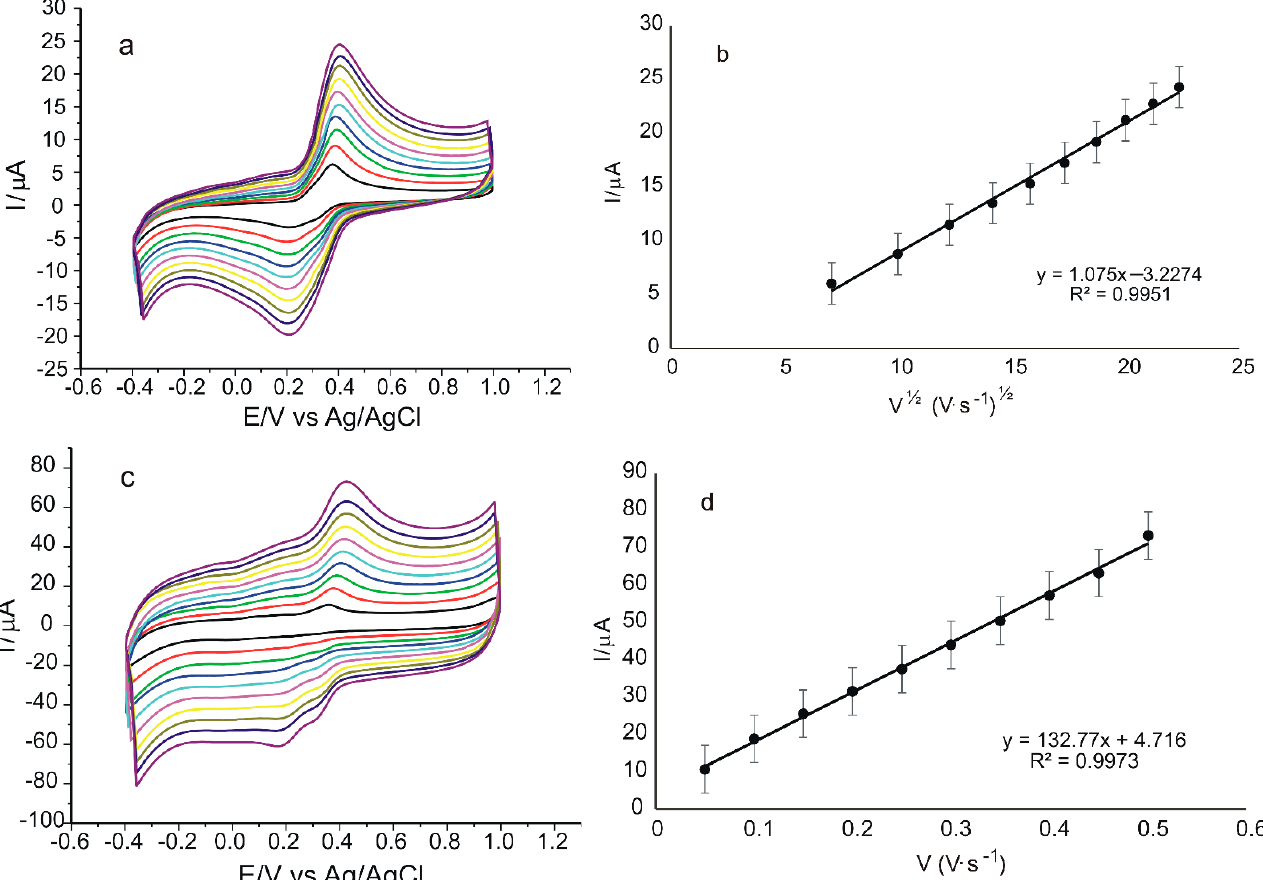
Figure 10. CVs of SPCE/GPHOX ( a ) and SPCE/GPHOX-Pentapeptide ( c ) immersed in 10 − 4 M verbascoside–0.1 M PBS at pH = 6.5 recorded at scan rates between 0.05 and 0.5 V·s − 1 . Linear dependence between Ipa and square root of scan rate in the case of SPCE/GPHOX ( b ) and linear dependence between Ipa and scan rate in the case of SPCE/GPHOX-Pentapeptide ( d ).